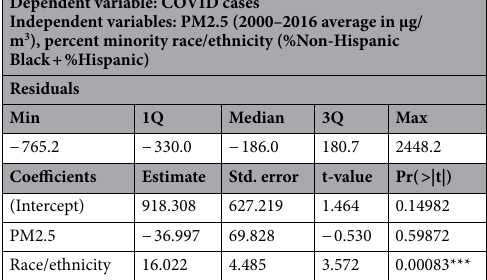
Multivariate linear regression of PM2.5, race/ethnicity, and COVID cases for the 50 most Populous counties in Texas Dependent variable: COVID cases Independent variables: PM2.5 (2000–2016 average in μg/ m 3 ), percent minority race/ethnicity (%Non-Hispanic Black +